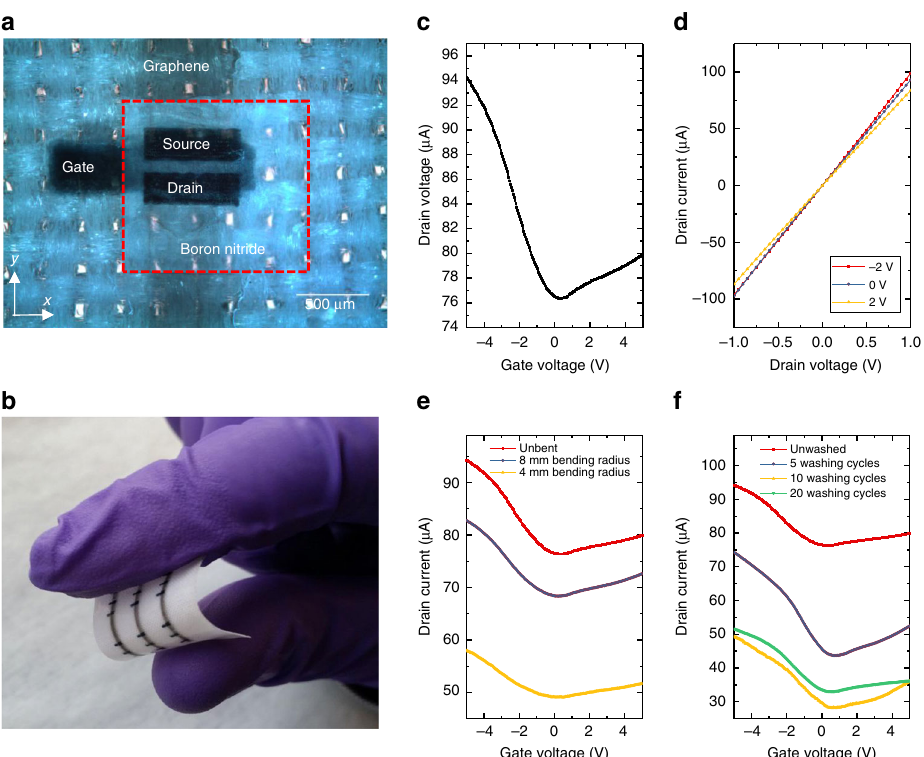
Fig. 5 Electrical characterisation of FET on textile. a Optical microscopy image of the inverted FET on polyester with a channel length of 80 μ m. b Image of an array of FETs on textile. c Transfer and d output characteristics of the textile FET at V ds = 1 V. e Transfer characteristics of the textile FET as a function of bending radius at V ds = 1 V. f Transfer characteristics of the textile FET before and after several washing cycles at V ds = 1